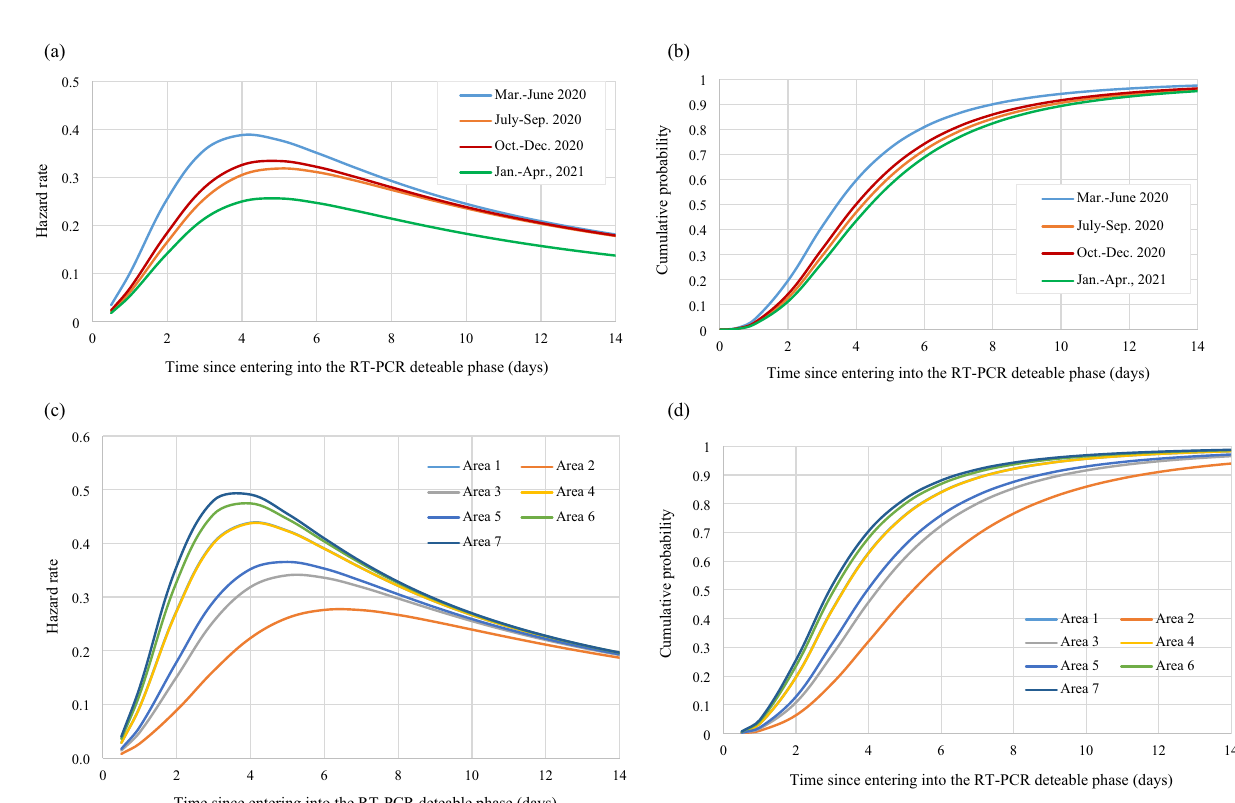
Time since entering into the RT-PCR deteable phase (days) Figure 1. Clinical characteristics of COVID-19 of developing symptoms for pre-symptomatic cases of COVID- 19. ( a ) Hazard rate ( b ) Cumulative probability of developing symptoms ( c ) Hazard rate by area during March and June 2020 ( d ) Cumulative probability of developing symptoms by area during March and June 2020, Taiwan; Area 1: Asia; Area 2: Oceania; Area 3: North and South America, excluding the U.S.; Area 4: U.S.; Area 5: Europe, excluding the U.K.; Area 6: U.K.; Area 7: